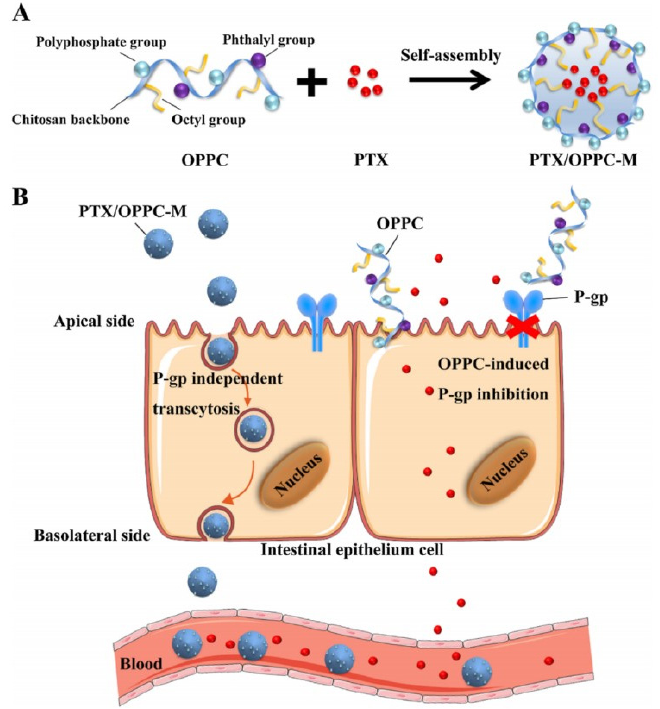
Figure 9. Scheme of the effect of OPPC micelles on improving the oral absorption of PTX. ( A ) The structure of OPPC and the strategy of constructing the PTX/OPPC micelles; ( B ) The hypothetical mechanism of improved oral absorption of PTX by OPPC micelles. Reprinted with permission from [14]. Copyright© 2018 Elsevier Ltd.